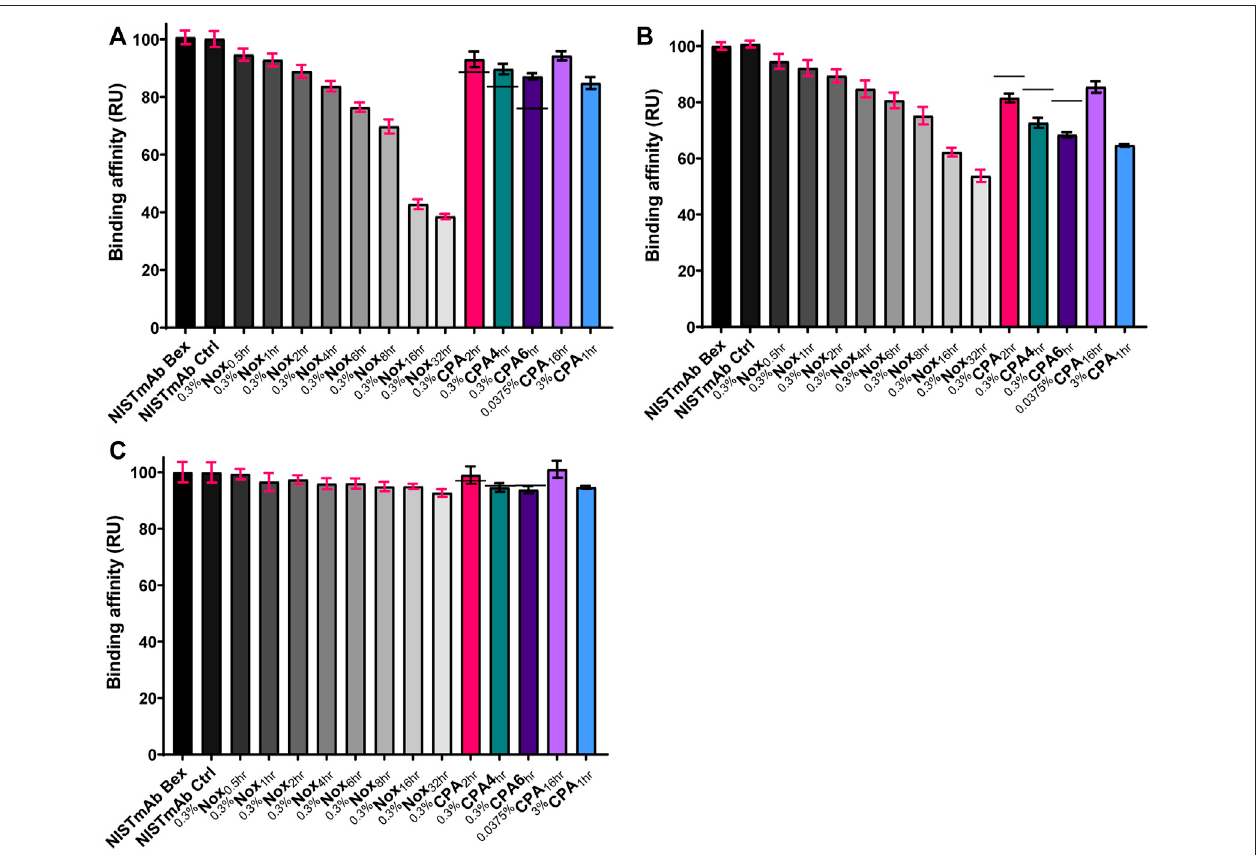
FIGURE6| Relative binding af fi nity ofNISTmAbsamples: (A) ProteinAbindingaf fi nity (RU) (B) Fpeptide binding af fi nity (RU) (C) ProteinLbinding af fi nity (RU). The standarddeviationofeachmeasurementisnotedwitherrorbars.Blackdashes( − )areusedinthe0.3%CPAsamplestodenotetherelativebindingaf fi nityfromequivlent timed Nox sample for comparison